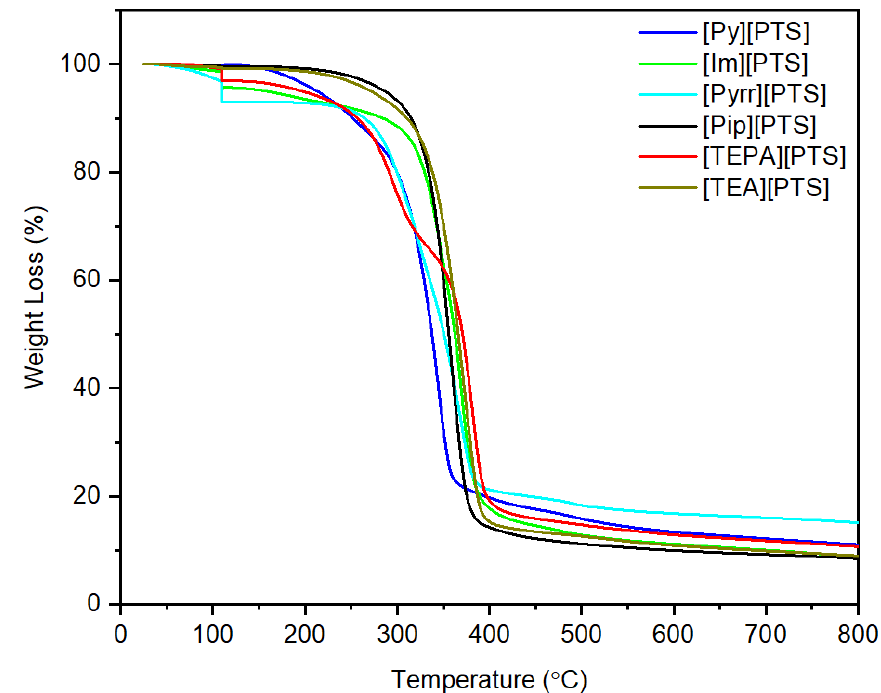
Figure 5. TGA thermogram of the p-toluene sulfonic acid [PTS] anion based protic ionic liquids.